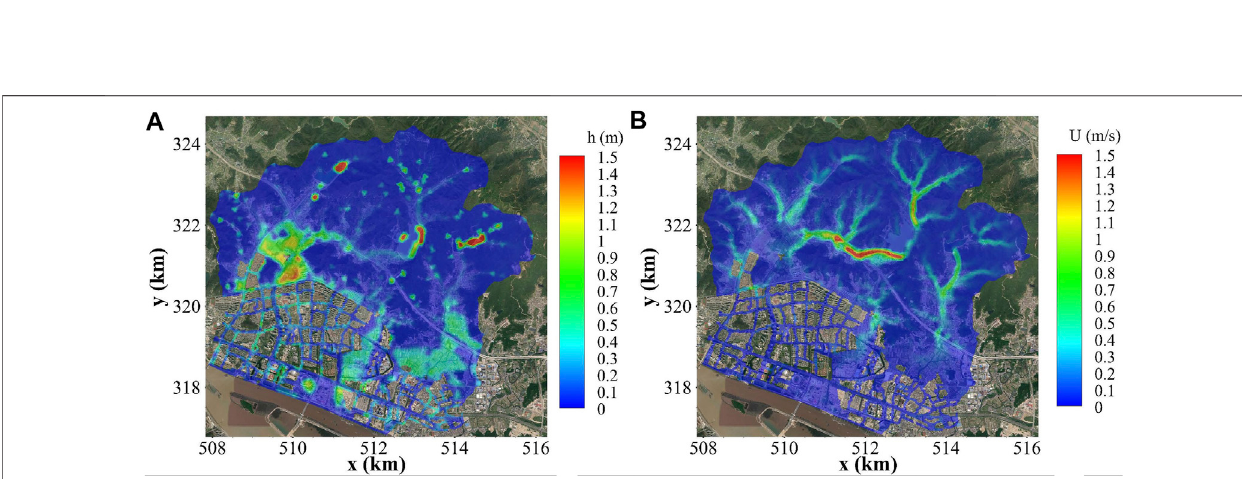
Figure 14 shows the comparison of temporal variations of water depth at the speci fi c points for Cases 1 and 3. By considering the in fi ltration effects in Case 3, a delay is observed for the start of water depth increase (i.e., land surface from dry to wet) at all points